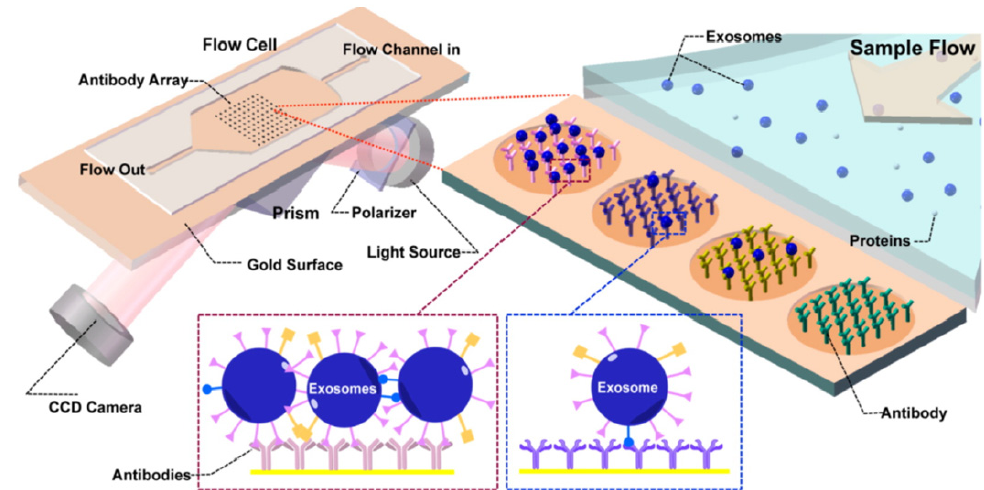
Figure 6. Principle of operation of SPR sensor incorporating an antibody array specific to exosomes transmembrane proteins. The binding of the exosomes causes a change in the refractive index of the laser that is detected by the CCD camera. Reproduced with permission from Zhu et al., 2014 (article link: https://pubs.acs.org/doi/10.1021/ac5023056 (accessed on 30 September 2021), Copyright 2014, American Chemical Society. Any future use of this content is subjected to permission from ACS Publications.